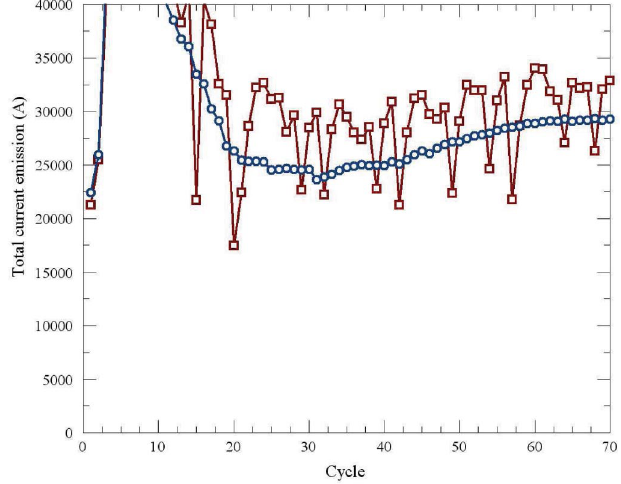
FIG. 3. (Color) Total simulation current as a function of iteration cycle with a charge averaging factor of (cid:4) (cid:5) 0 : 05 . Blue line: CRAD diode. Red line: rod-pinch